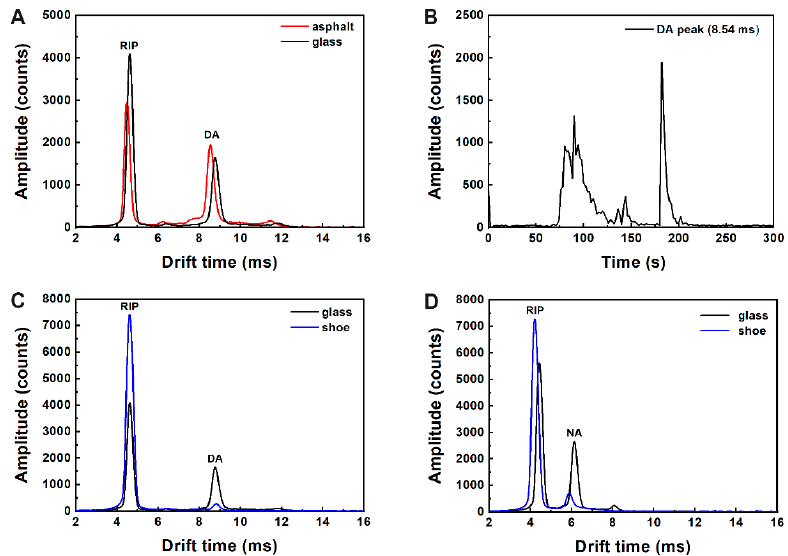
Figure 5. ( A ) LTP-IMS analysis of DA from glass and asphalt surfaces. ( B ) Time trace of the domi- nant IMS product ion peak of DA during a four-minute operation of the LTP. ( C , D ) LTP-IMS anal- ysis of DA and NA from contaminated glass and shoe surfaces.